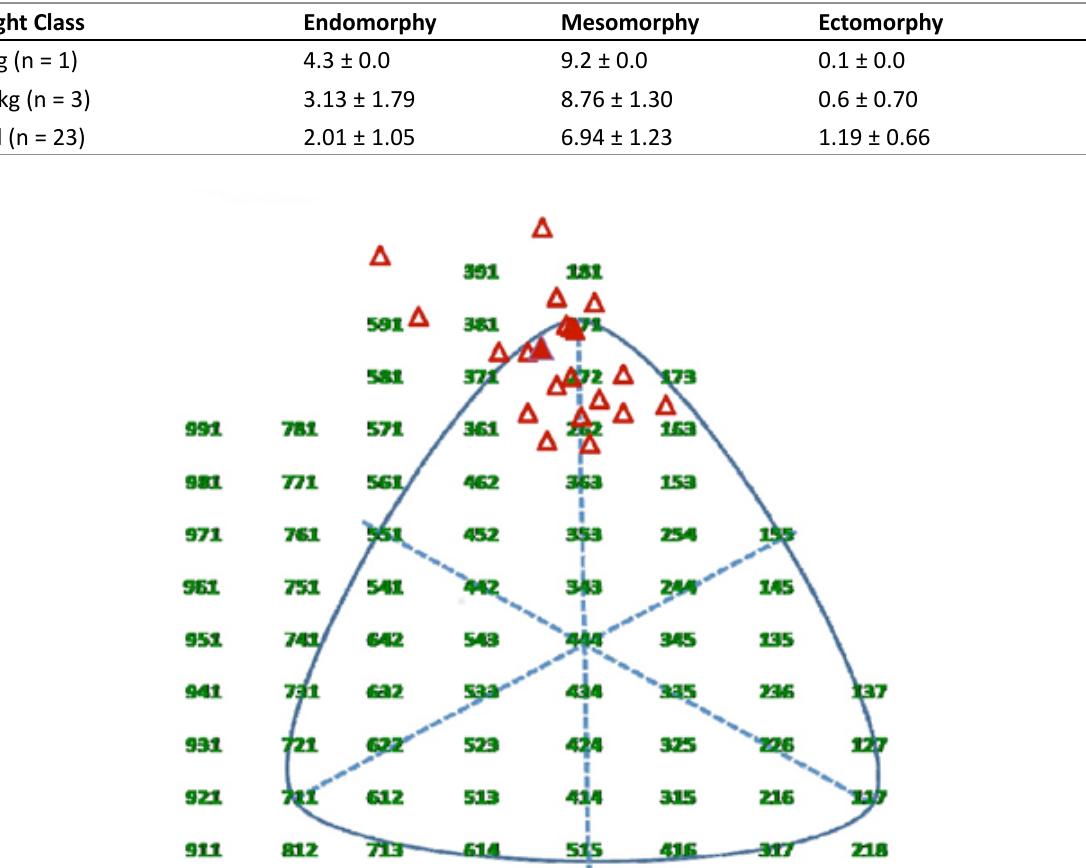
Figure 1. Somatotype features of elite Azerbaijani senior Greco-Roman wrestlers. D = somatotype mean (1.19 – 6.94 –